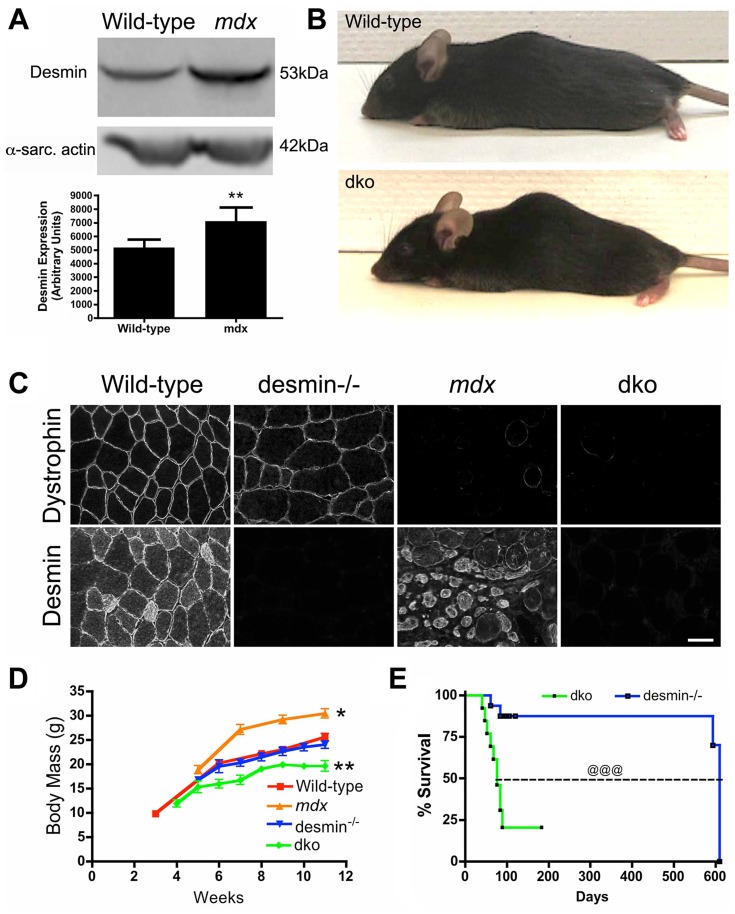
The genetic deletion of desmin from mdx4cv mice reduces body mass and survival.
A) Desmin expression was significantly increased in the mdx4cv skeletal muscles. Bars represent the mean +/− S.D. densitometry of desmin expression from n = 7 wild-type and n = 6 mdx4cv gastrocnemius muscles. B) Photograph of representative wild-type and dko mice. Note that the dko mice develop a mild kyphosis at 11 weeks of age. C) Confirmation of genotype by immunostaining of frozen gastrocnemius muscle sections with antibodies to dystrophin and desmin. Scale bar  = 50 µm D) Mean +/− S.D. body mass of wild-type (n = 5), mdx4cv (n = 4), desmin−/− (n = 5) and dko mice (n = 9). E) Kaplan-Meyer survival analyses demonstrating the significantly shortened lifespan of dko mice (n = 13) compared with desmin−/− mice (n = 16). *P<0.05, **P<0.01 compared with wild-type. @@@P<0.001 compared to desmin−/−.